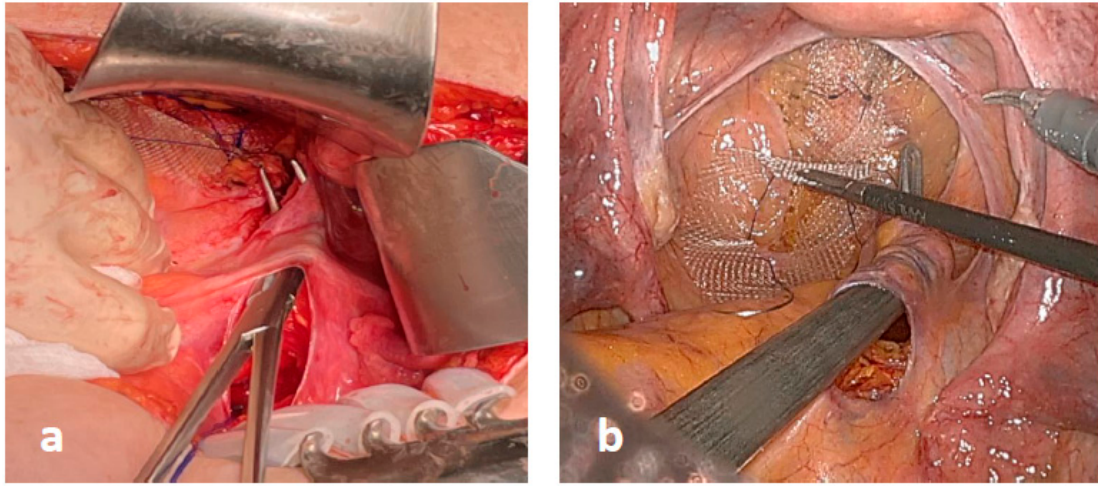
Figure 2. A retroperitoneal tunnel was created in open ( a ) and robotic ( b ) surgery.